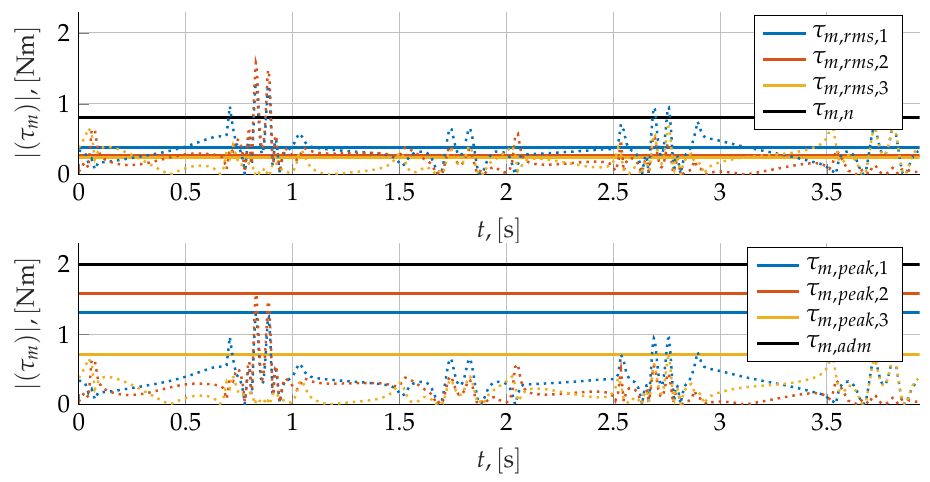
Figure 23. Top panel : RMS torques at the motor shaft for i t = 9; the black line represents the rated torque of the motor. Bottom panel : torques at the motor shaft for i t = 9; the black line represents the maximum admissible torque of the drive system.